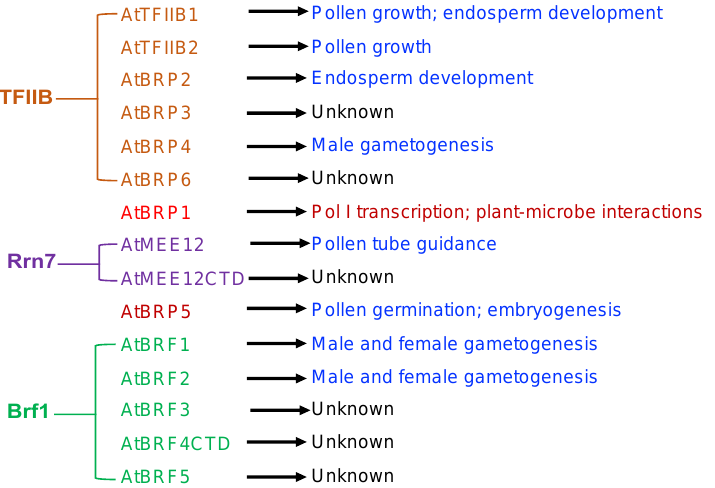
Figure 2. Expansion and functional diversification of Arabidopsis TFIIB-like proteins. The possible evolutionary relationship of Arabidopsis TFIIB-like factors with eukaryotic TFIIB, Rrn7 and Brf1 general transcription factors is based on the phylogenetic analysis, which has also shown Brp1-like and Brp5-like proteins to be present only in plant and algae species [9]. Molecular and genetic analysis has revealed that a majority of these Arabidopsis TFIIB-like proteins play crucial roles in plant reproductive processes.